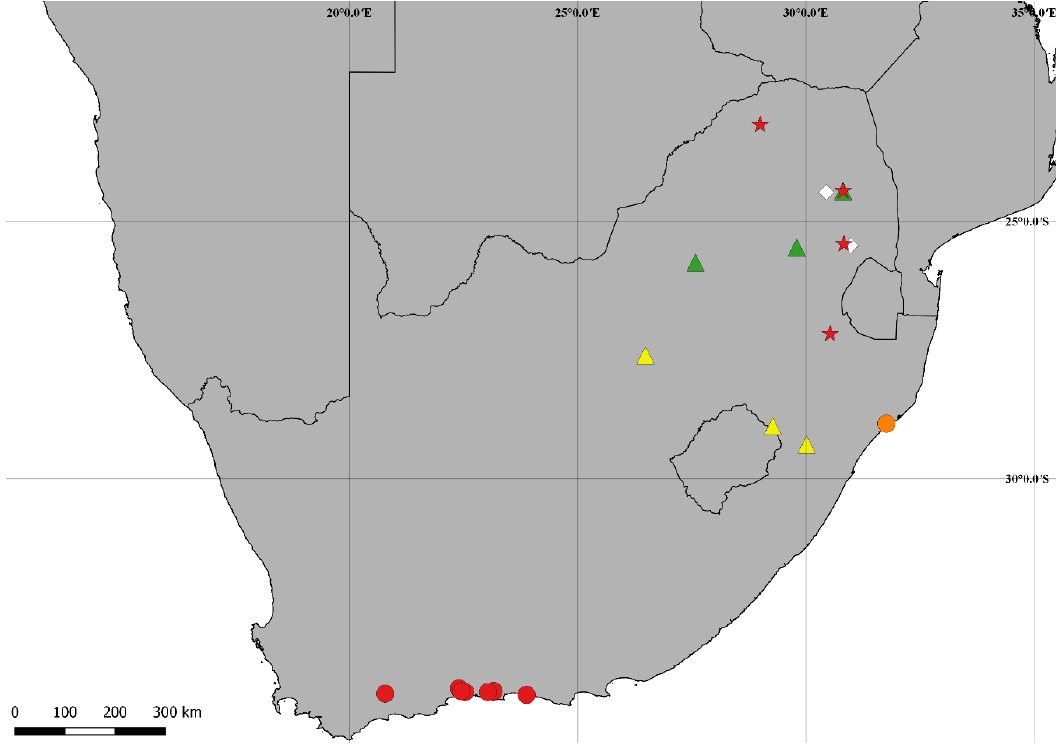
Figure 13. Known distribution of Cis bicaesariatus sp. n. (green triangle), Cis lacinipennis sp. n. (yellow triangle), Cis makrosoma sp. n. (white diamond), Cis mpumalangaensis sp. n. (red star), Cis umlalaziensis sp. n. (orange circle) and Cis westerncapensis sp. n. (red circle).